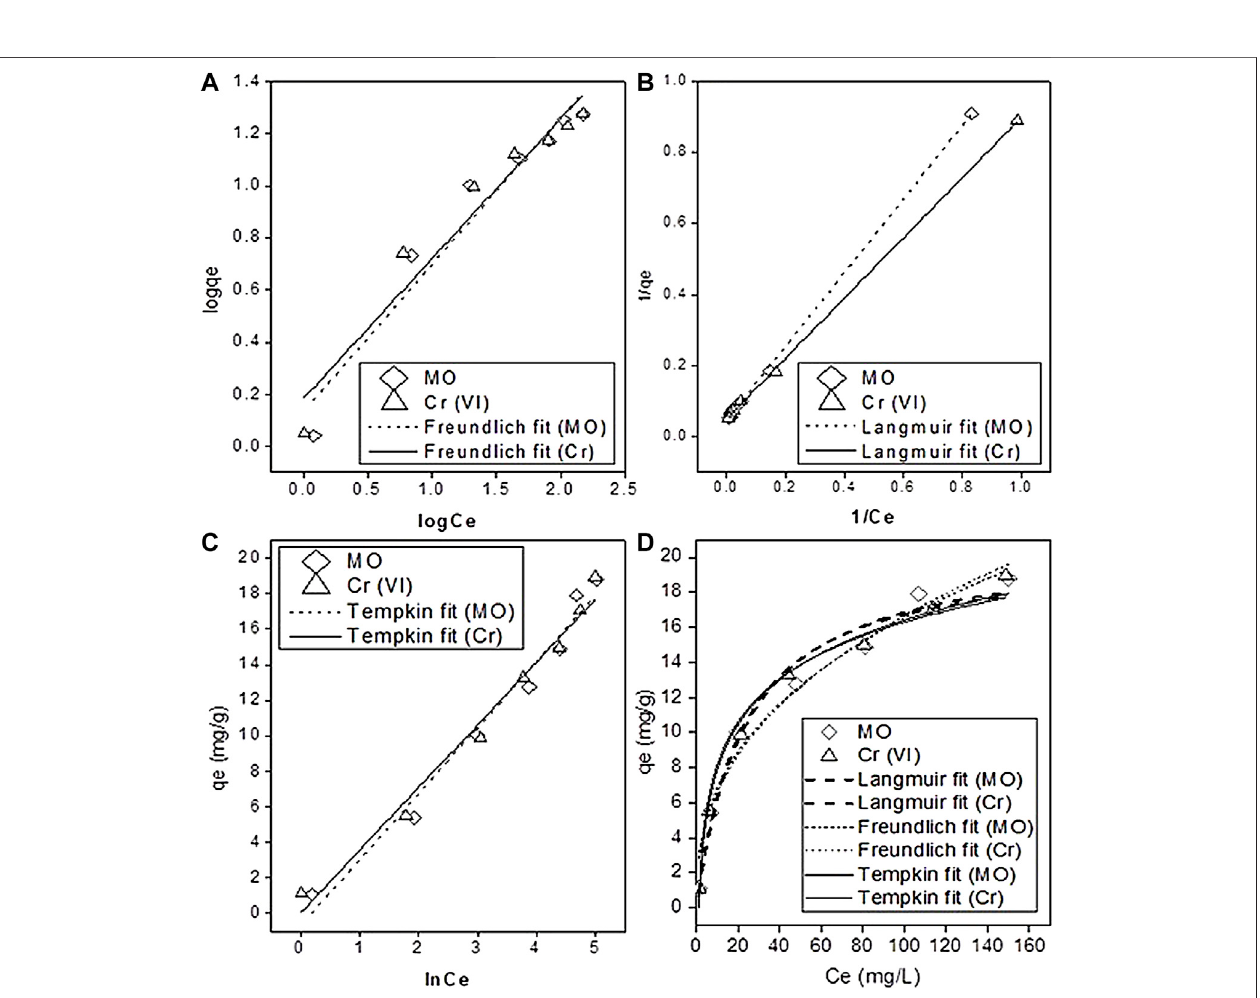
FIGURE 6 | Adsorption isotherms. (A) Freundlich, (B) Langmuir, (C) Tempkin isotherm model, and (D) nonlinear isotherm models.